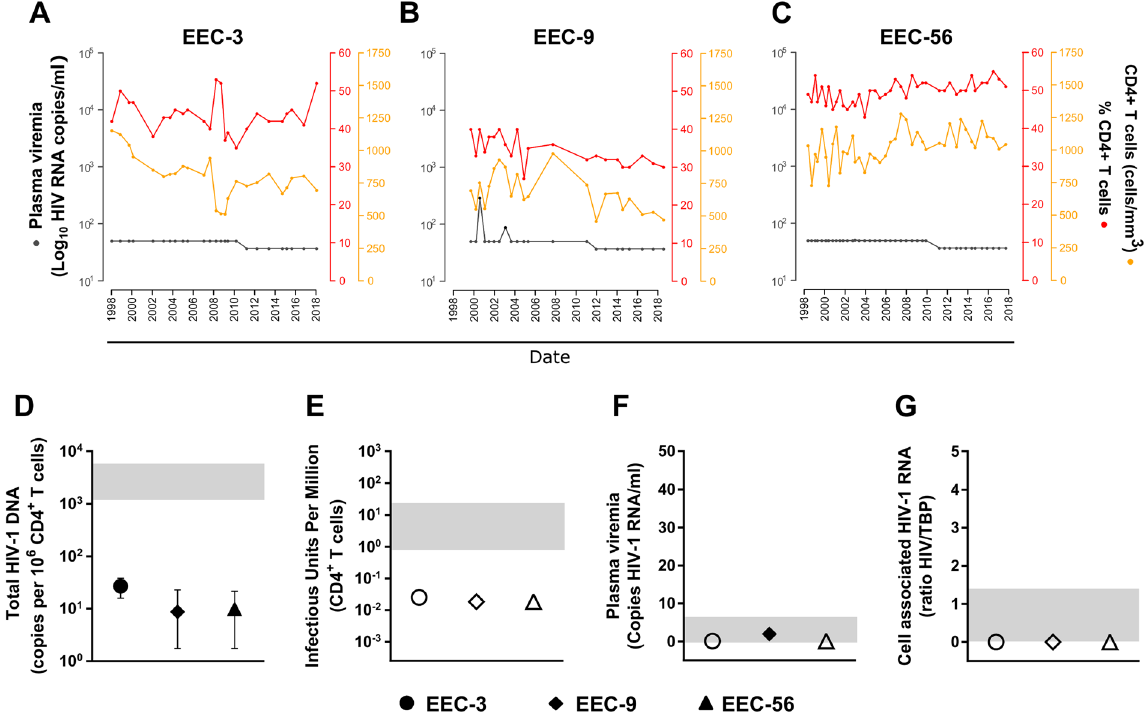
Figure 1. Clinical characteristics and HIV-1 reservoir quantification. ( A–C ) Plasma RNA viral load, absolute CD4 + and CD4 + T cell percentage over time in the individuals studied. Grey symbols for viral load indicate values below the detection limit. ( D – G ) Viral reservoir measurements of ( D ) total HIV-1 DNA, ( E ) Infectious Units per million cells (IUPM) in a qVOA assay, ( F ) ultrasensitive plasma viral load and ( G ) cell associated RNA (caHIV-1-RNA). Open symbols indicate undetectable values. Light grey bands are the interquartile range from standard HIV-1-infected individuals under treatment 26